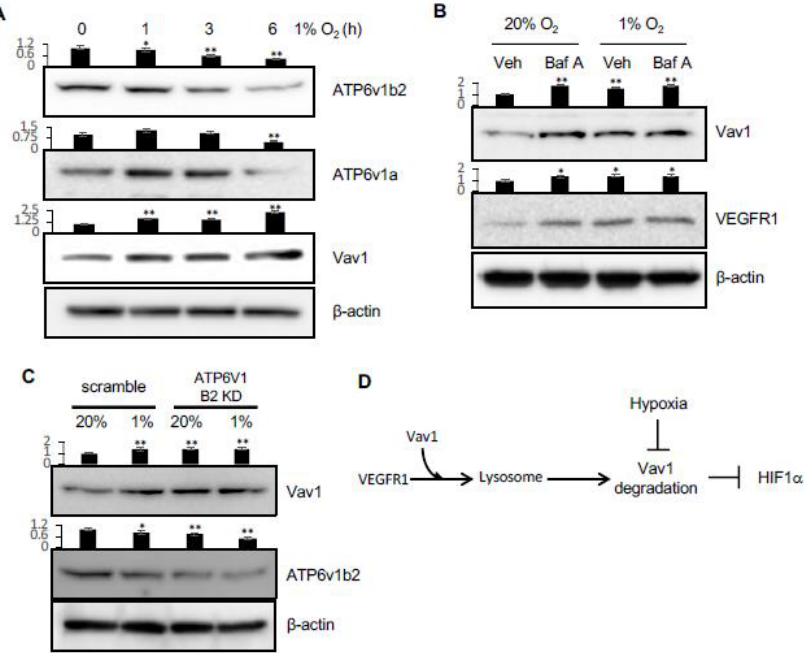
Figure 5. Hypoxia regulates lysosomal activity via v-ATPase and Vav1 levels. ( A ) HUVEC cells were incubated in hypoxia for 0, 1, 3 or 6 hours. Vav1, ATP6v1a, and ATP6v1b2 were measured in the total lysates. ( B ) HUVEC were incubated in normoxia or hypoxia for 5 h in the presence or absence of 100 nM of Bafilomycin A (Baf A). Vav1 and VEGFR1 were measured by Western blot of the total lysates. ( C ) HUVEC were transduced with ATP6v1b2 shRNA-expressing lentivirus or scrambled shRNA virus for 72 h, and then incubated in normoxia or hypoxia for 5 h. Vav1 and ATP6v1b2 levels were measured by Western blot of the total lysate. ( D ) VEGFR1 carries Vav1 to the lysosome in the cell. Vav1 is degraded in the lysosome, which downregulates HIF1α. Hypoxia blocks the lysosomal degradation. Mean ± SD, * p < 0.05, ** p < 0.01. The whole western blot images please find in Figure S4.